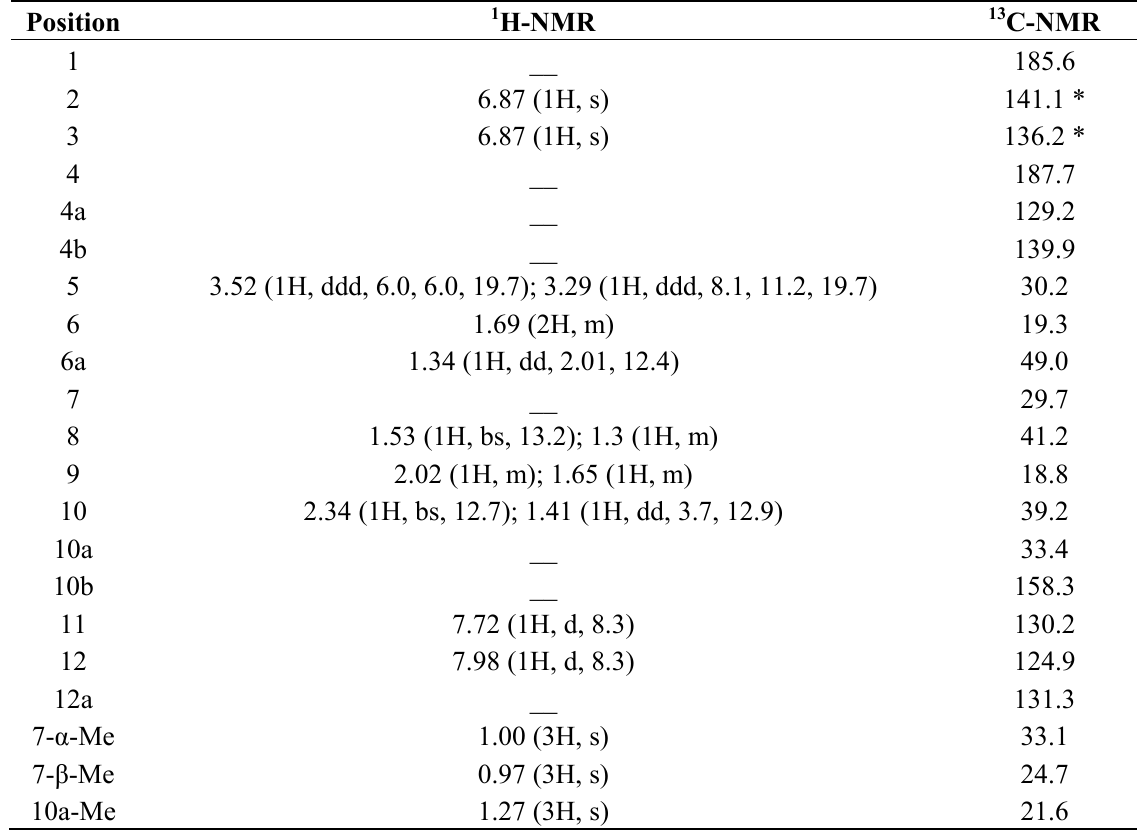
Table 2. 1 H-NMRchemical shifts, δ (ppm), coupling constants J (H,H) (Hz), and 13 C-NMR chemical shifts, δ (ppm), for compound 11